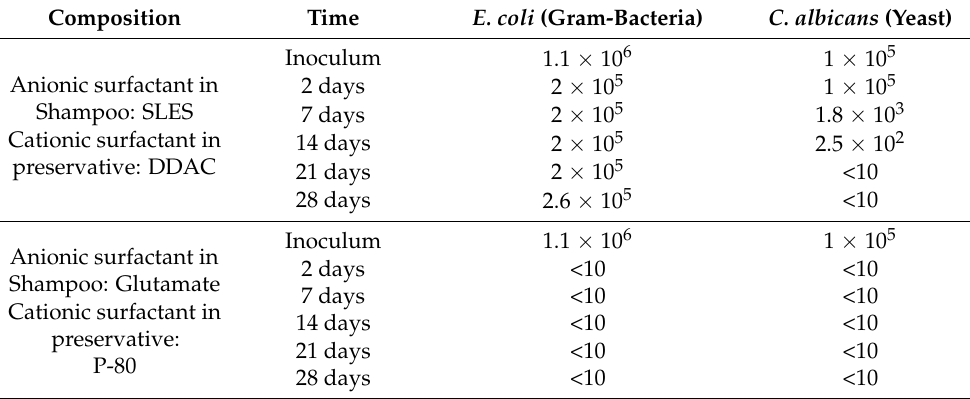
Table 4. Challenge tests of 0.5% preservative mixtures containing DDAC or P-80 in anionic shampoo cosmetic formulation containing SLES or glutamate, respectively.